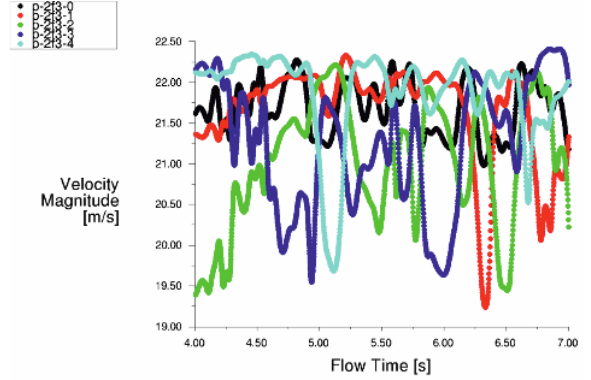
Figure 10: Velocity behavior at the flowmeter of metering run #3